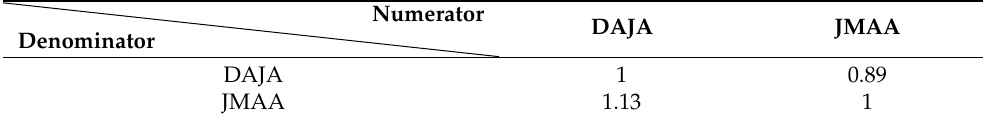
Table 3. ARTEC in different timeslot periods between DAJA and JMAA [12]. Denominator